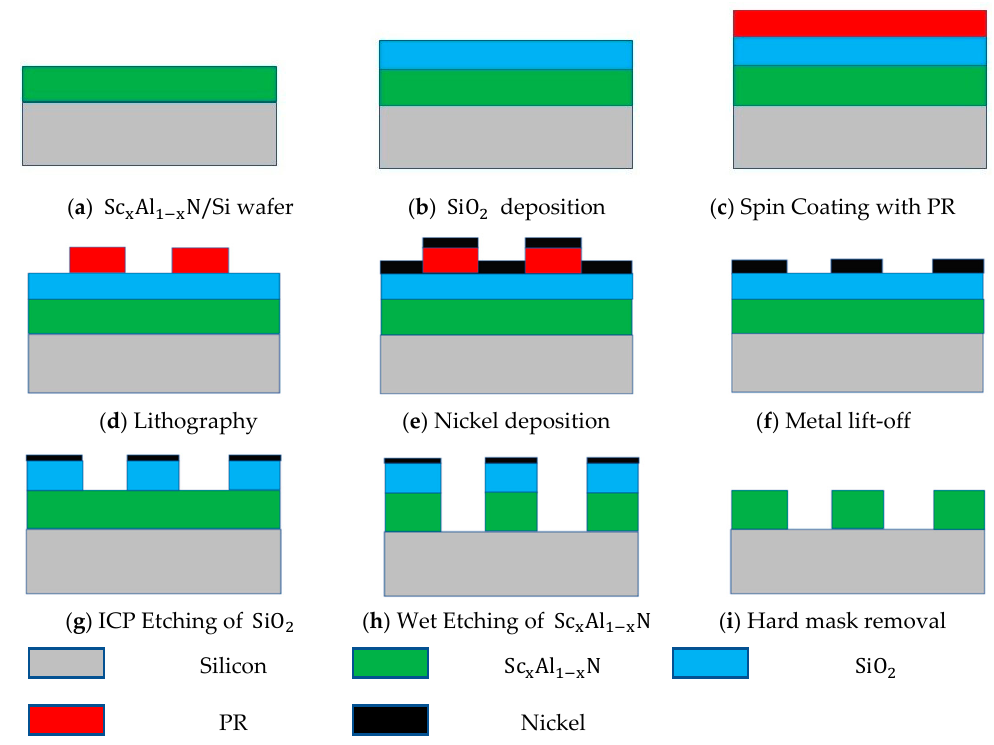
Figure 2. Process flow for sample preparation and etching of Sc x Al 1 − x N thin